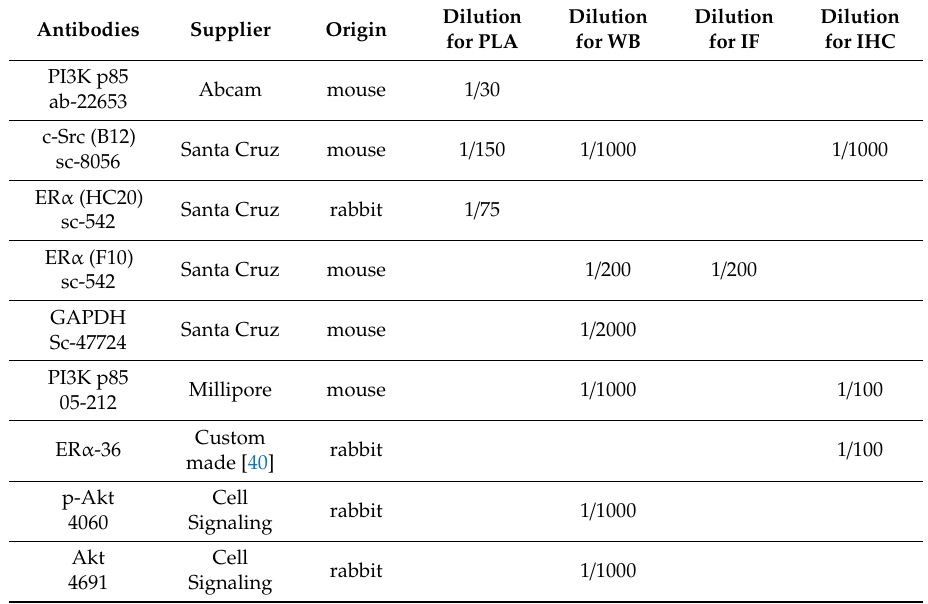
Table 1. Information of primary